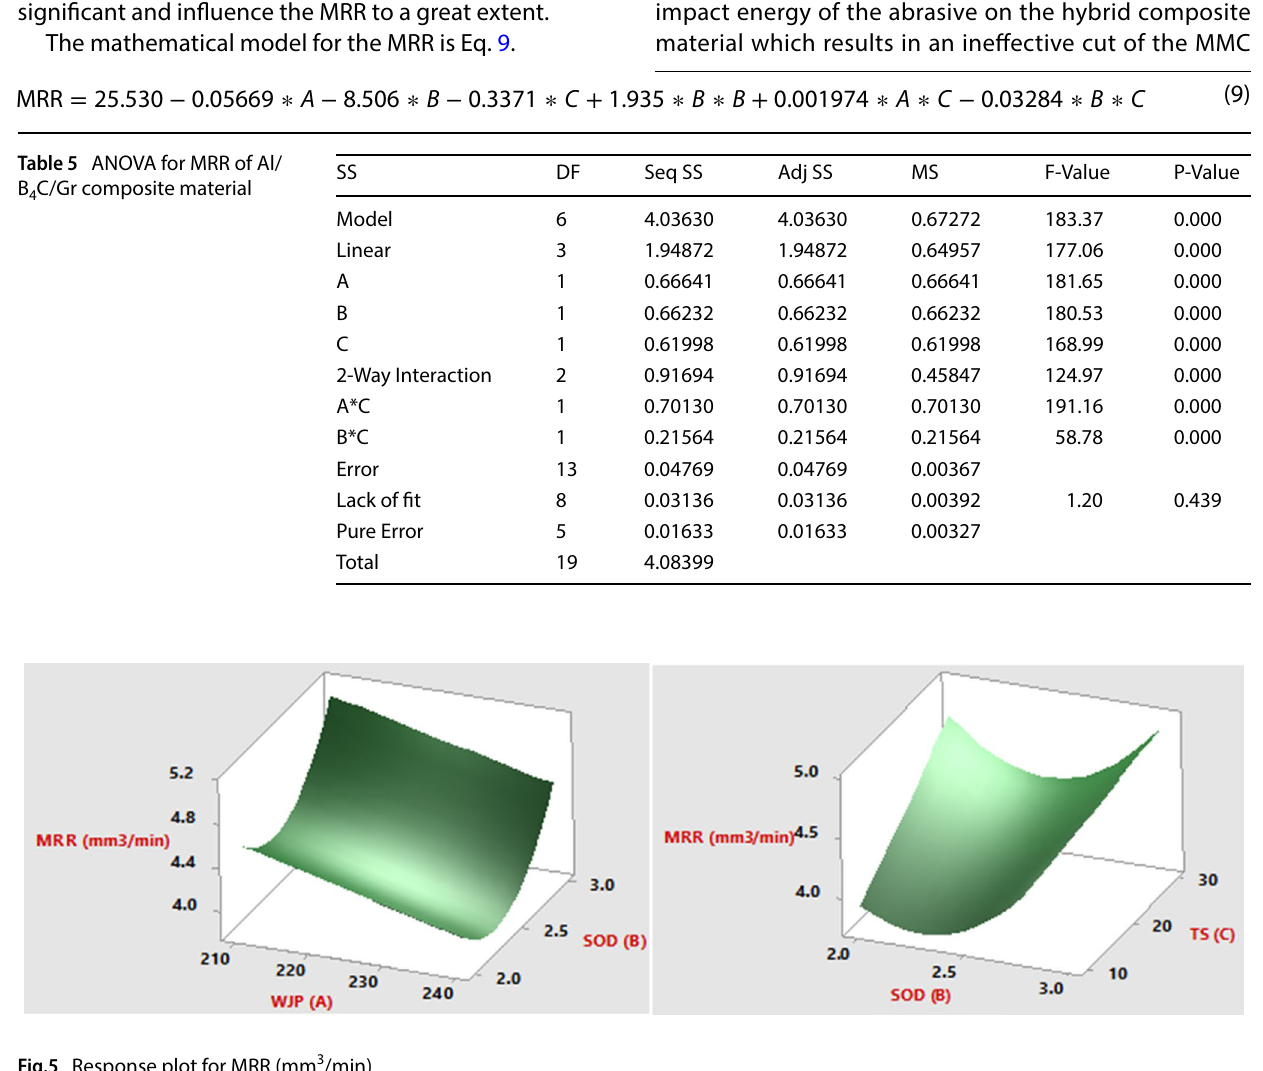
Fig.5 Response plot for MRR (mm 3